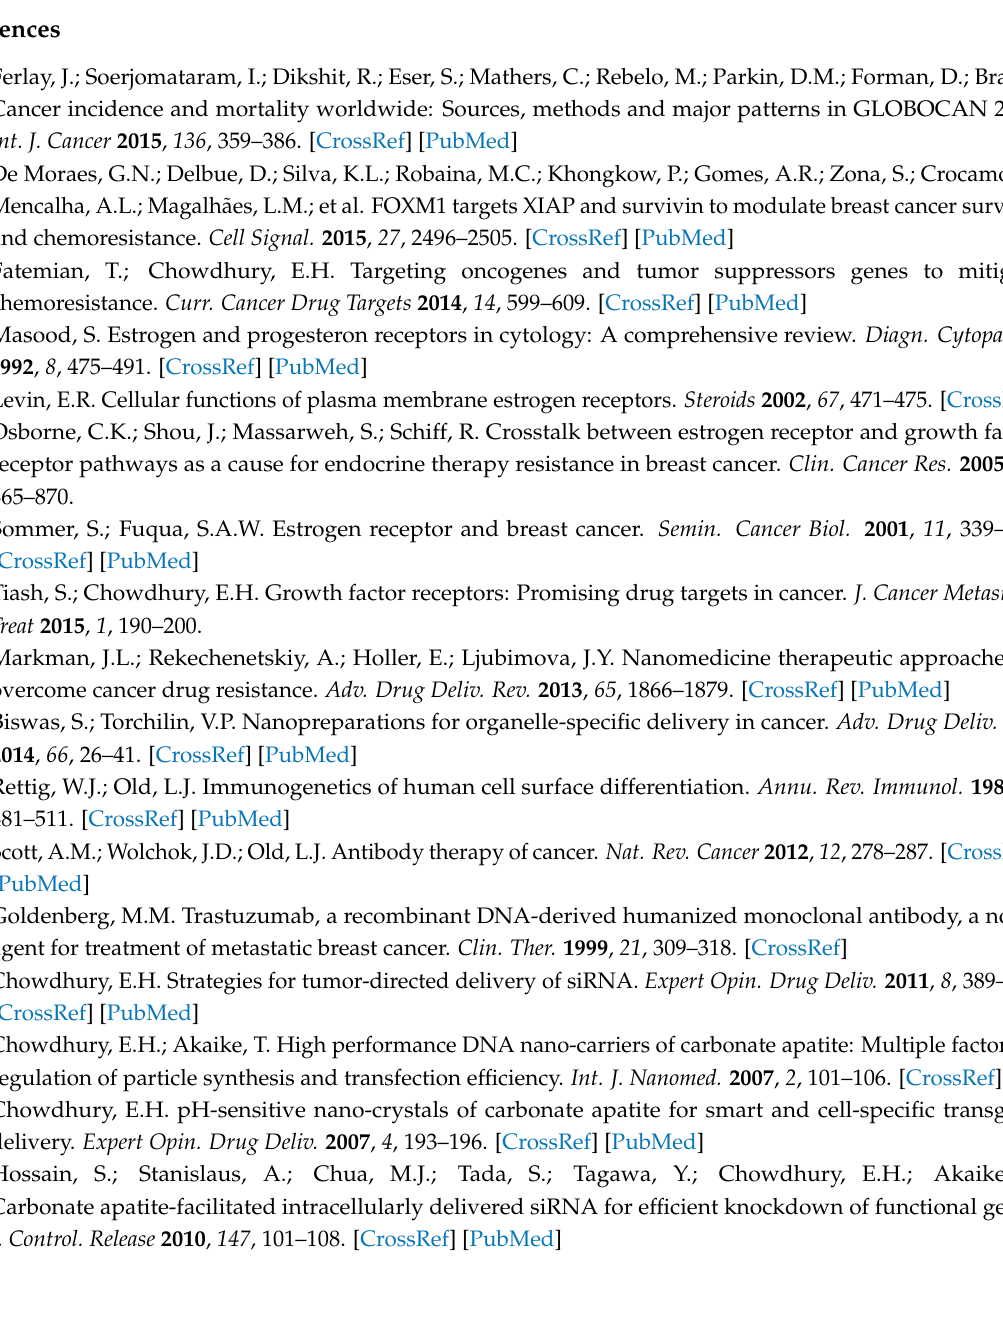
Figure S1: Images of CA particles under a scanning electron microscope (SEM), Incorporation of siRNA along with CA caused no further increase in the size (data not shown here). CA nanoparticles were prepared as mentioned in the “materials and methods” section, with the incorporation of appropriate amount of CaCl2 in media, followed by incubation at 37 ◦ C for 30 min. The resulting nanoparticles were centrifuged at 13,000 rpm for 10 min and the supernatant was discarded. The pellet was resuspended in 200 µ L mili-Q water. 3 µ L of the particle suspension was placed on the glass slide to dry at room temperature. Platinum sputtering was applied on the dried sample and the image was observed through the field-emission SEM. Scale bar, 300